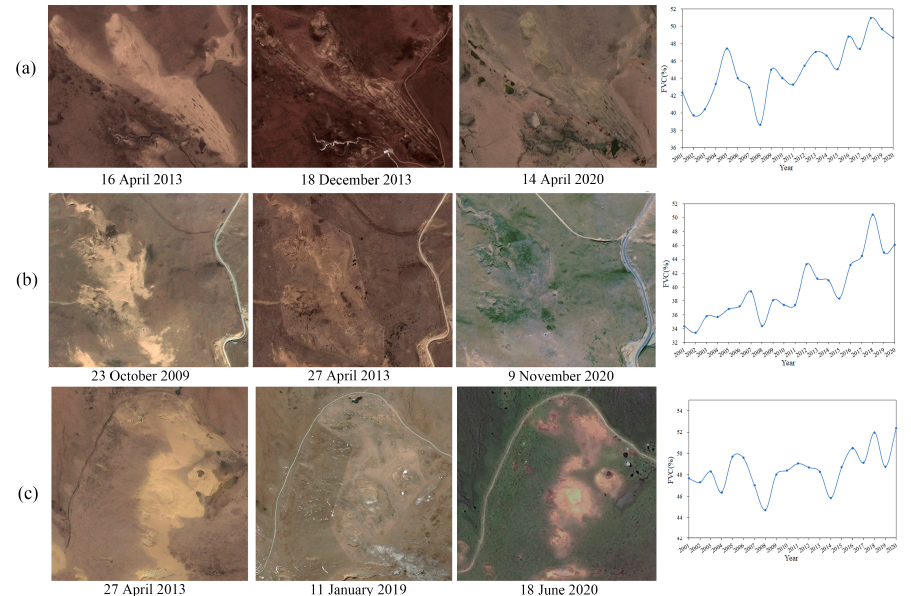
Figure 4. Changes in trend of fractional vegetation cover (FVC) in Zoige county from 2001 to 2020: ( a – c ) are the remote-sensing image comparison maps and vegetation coverage change time-series map of three typical ecological engineering implementation points. High-resolution remote-sensing images are from Google Earth and Chinese GF-1 satellites.